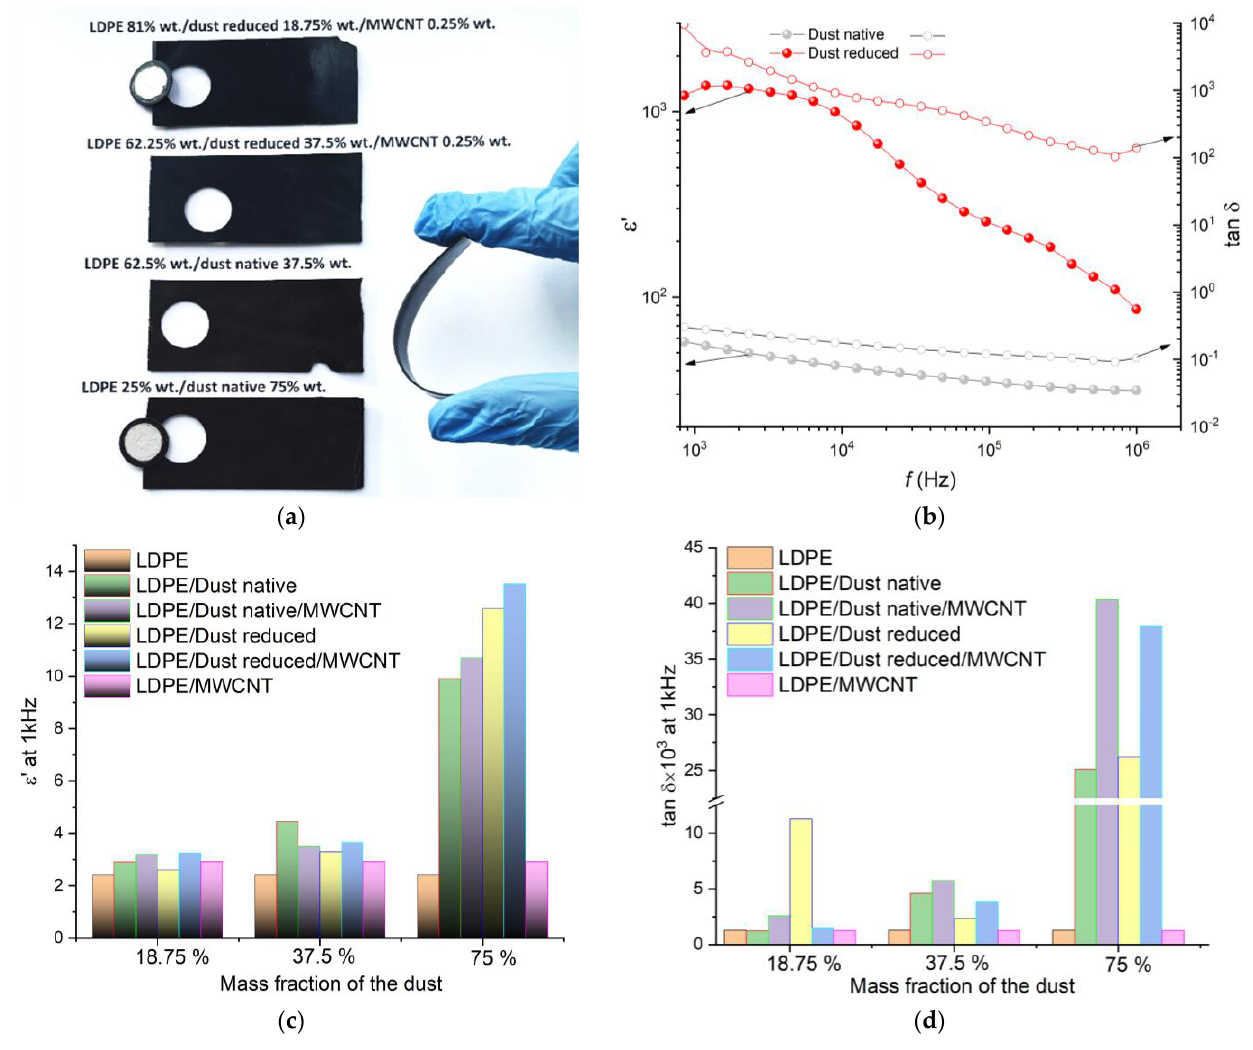
Figure 7. Images of composite films based on ( a ) filled LDPE, ( b ) the frequency dependence of dust permittivity, ( c , d ) permittivity and dielectric loss tangent of composite films with different qualitative and quantitative composition at 1 kHz.